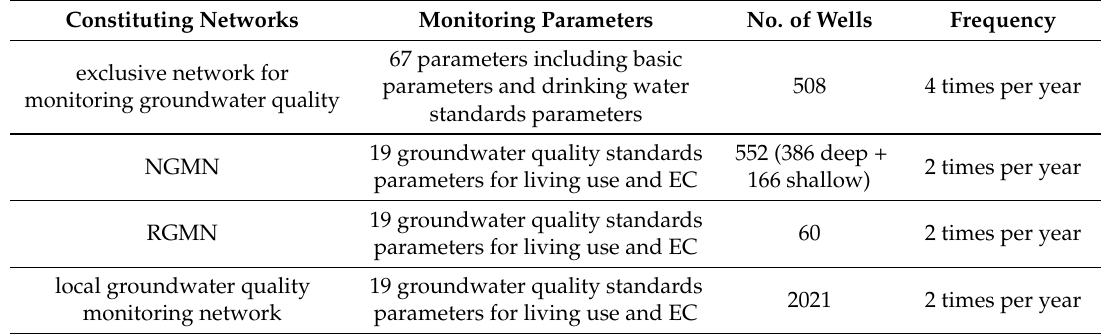
Table 3. Details of the Groundwater Quality Monitoring Network of Korea (as of December